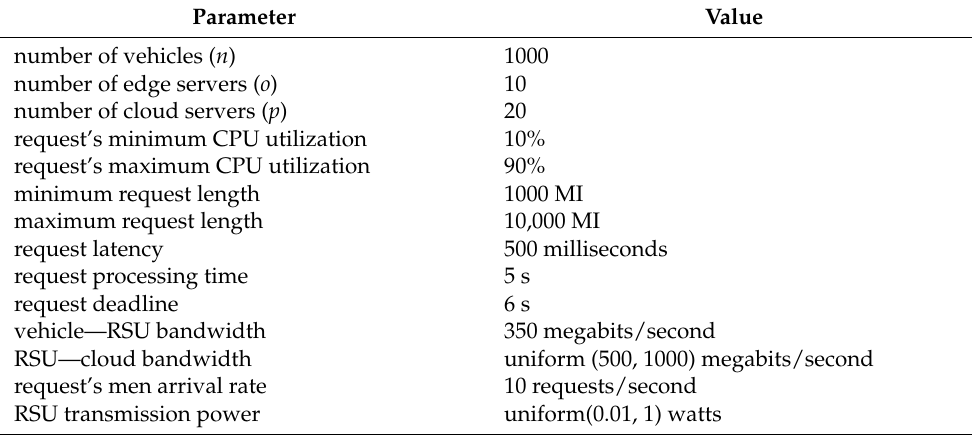
Table 4. Experimental